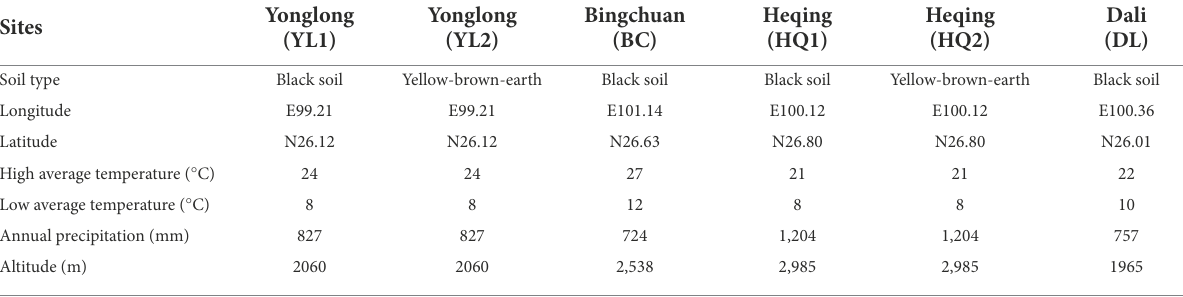
TABLE 1 The detailed description of soil sample collection and